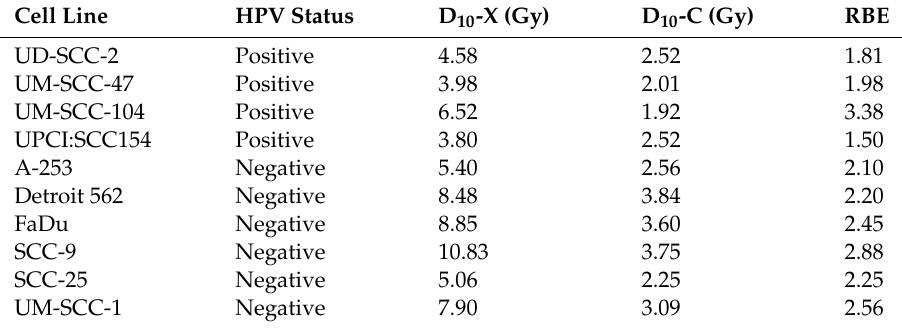
Table 2. D 10 and RBE in HPV-positive and negative cell